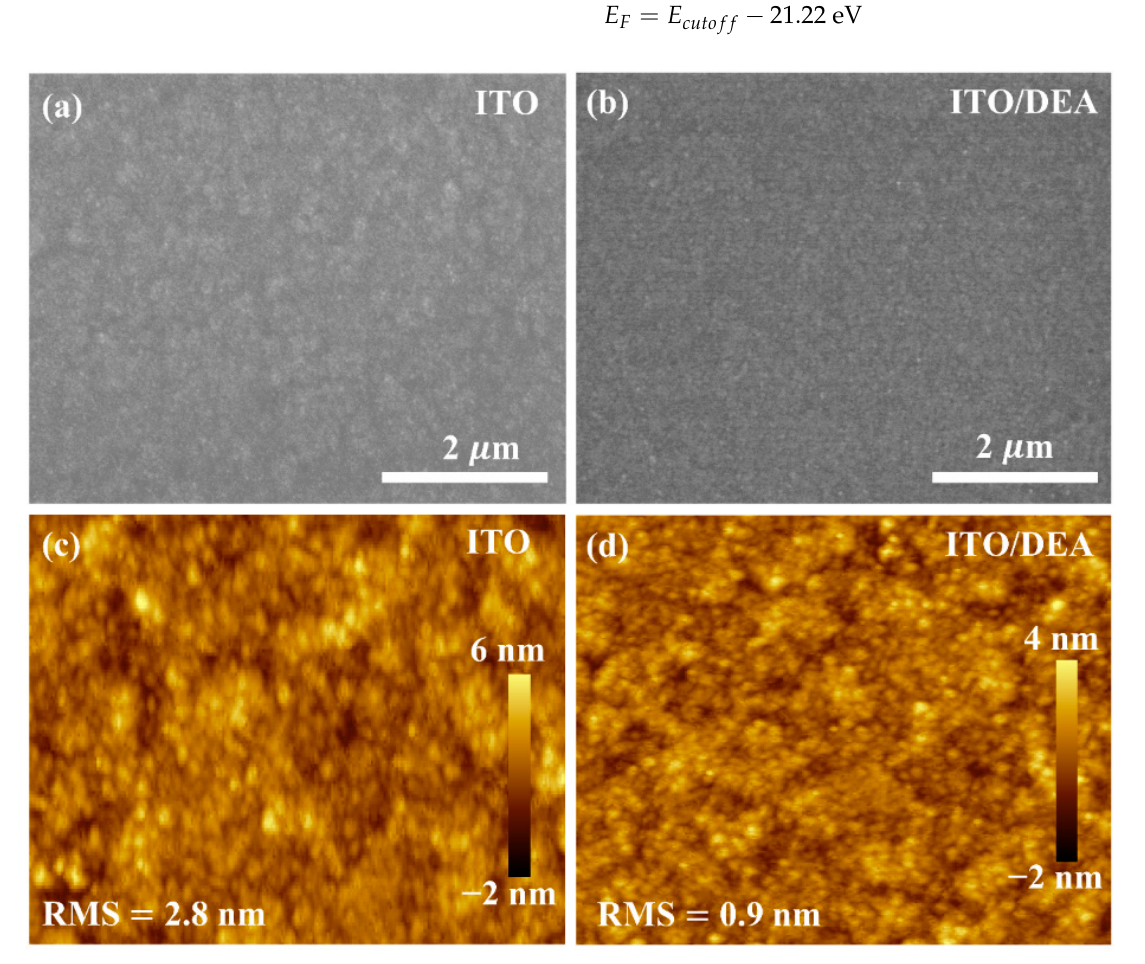
Figure 2. SEM images of the ITO substrate ( a ), ITO/DEA substrate ( b ), AFM images of ITO substrate ( c ), and ITO/DEA substrate ( d ).